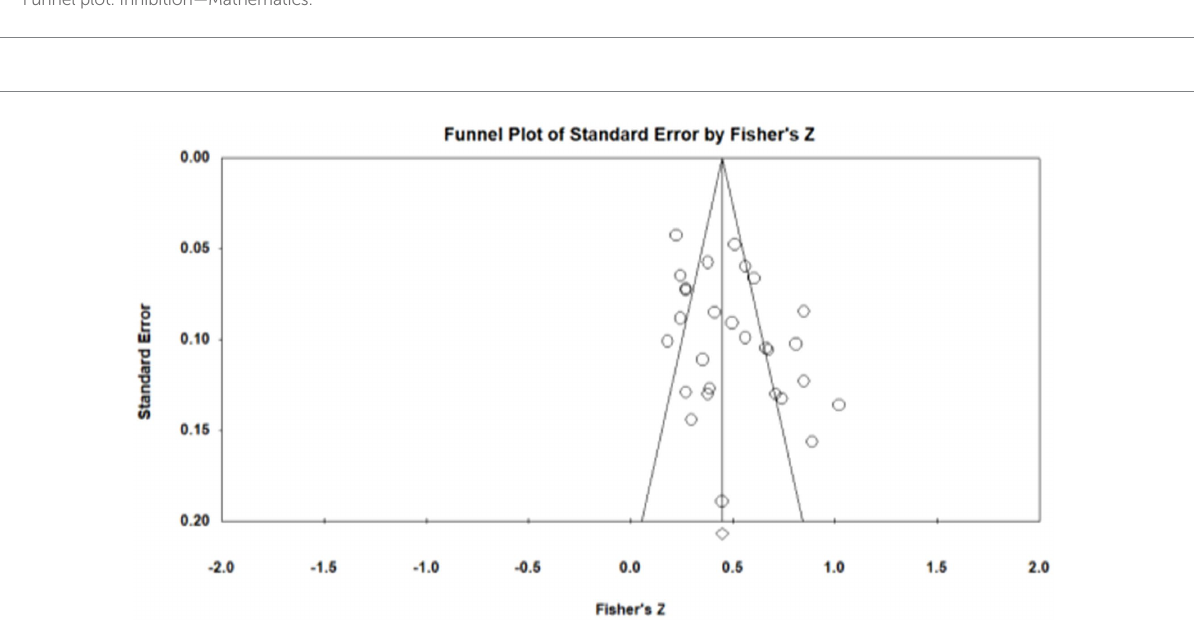
FIGURE 3 Funnel plot. Inhibition—Mathematics.